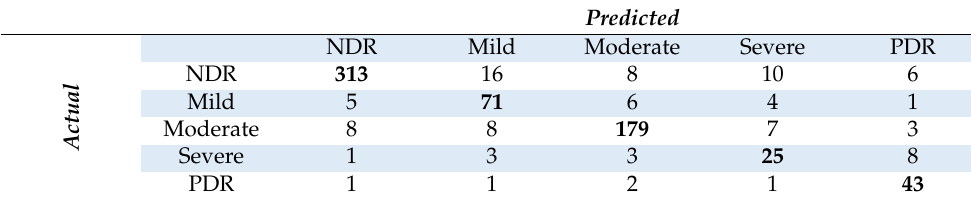
Table 5. Confusion matrix for five classes.